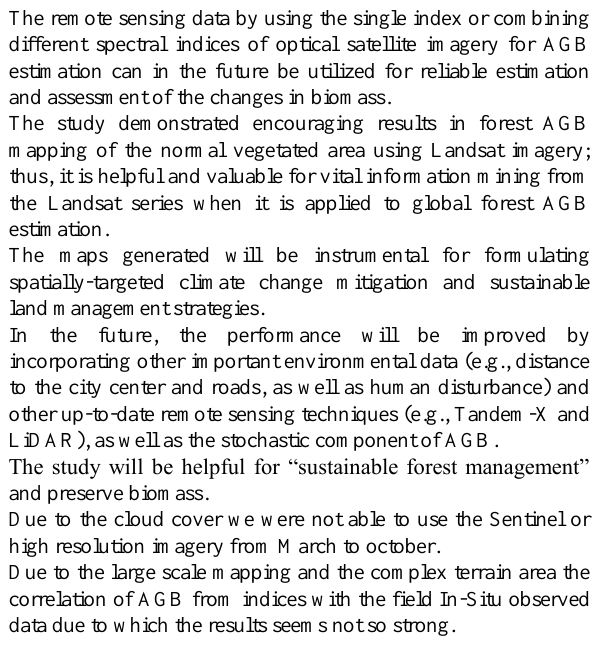
Figure 5. Carbon StockLandsat-8 of Gilgit-Baltistan of year